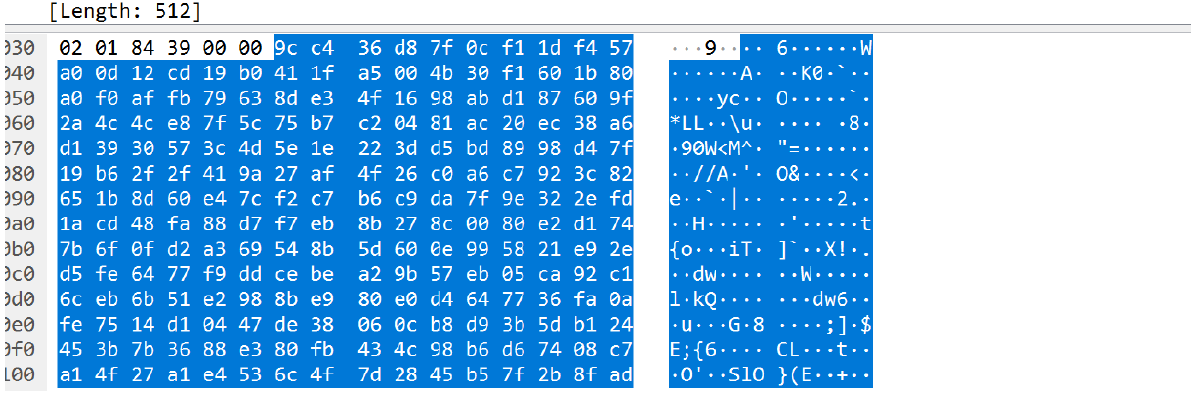
Figure 24. Wireshark snapshot of the encrypted data frame. 5.5. Merkle Tree Implement error detection within the block content and the blockchain by using the Merkle tree proposed earlier in this paper in Section 3.11.1 to improve the prototype sys- tem. However, due to time constraints, it was not possible to implement this feature at this time. 5.6. Running on Unix-Like Systems and Windows The application is tested on multiple Unix-like operating systems such as Raspberry Pi, which is Debian-based, and Windows 10 operating systems. There are no compatibility issues as long as all the libraries are installed correctly and the directory of the files is identified.